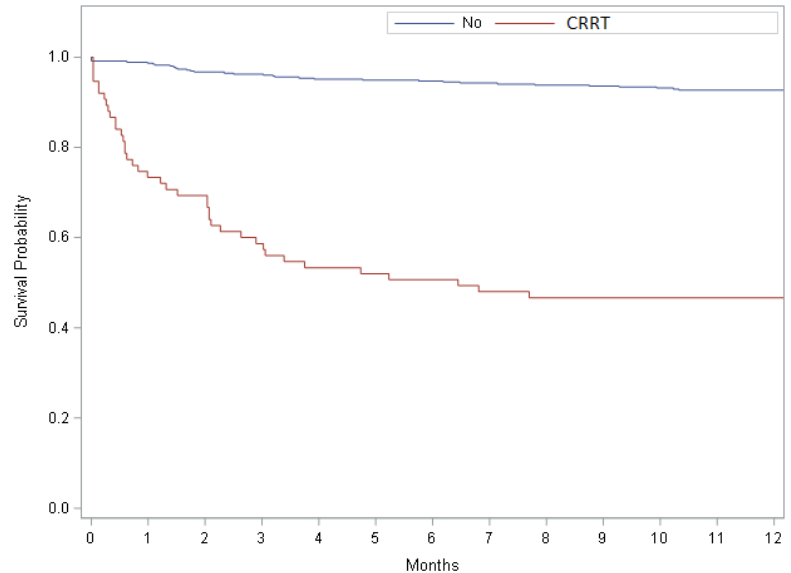
Figure 1. Kaplan–Meier curve showing survival between the two groups (continuous renal replace- Figure 1. Kaplan – Meier curve showing survival between the two groups (continuous renal ment therapy (CRRT) in the first week after transplant vs. no CRRT). replacement therapy (CRRT) in the first week after transplant vs. no CRRT).